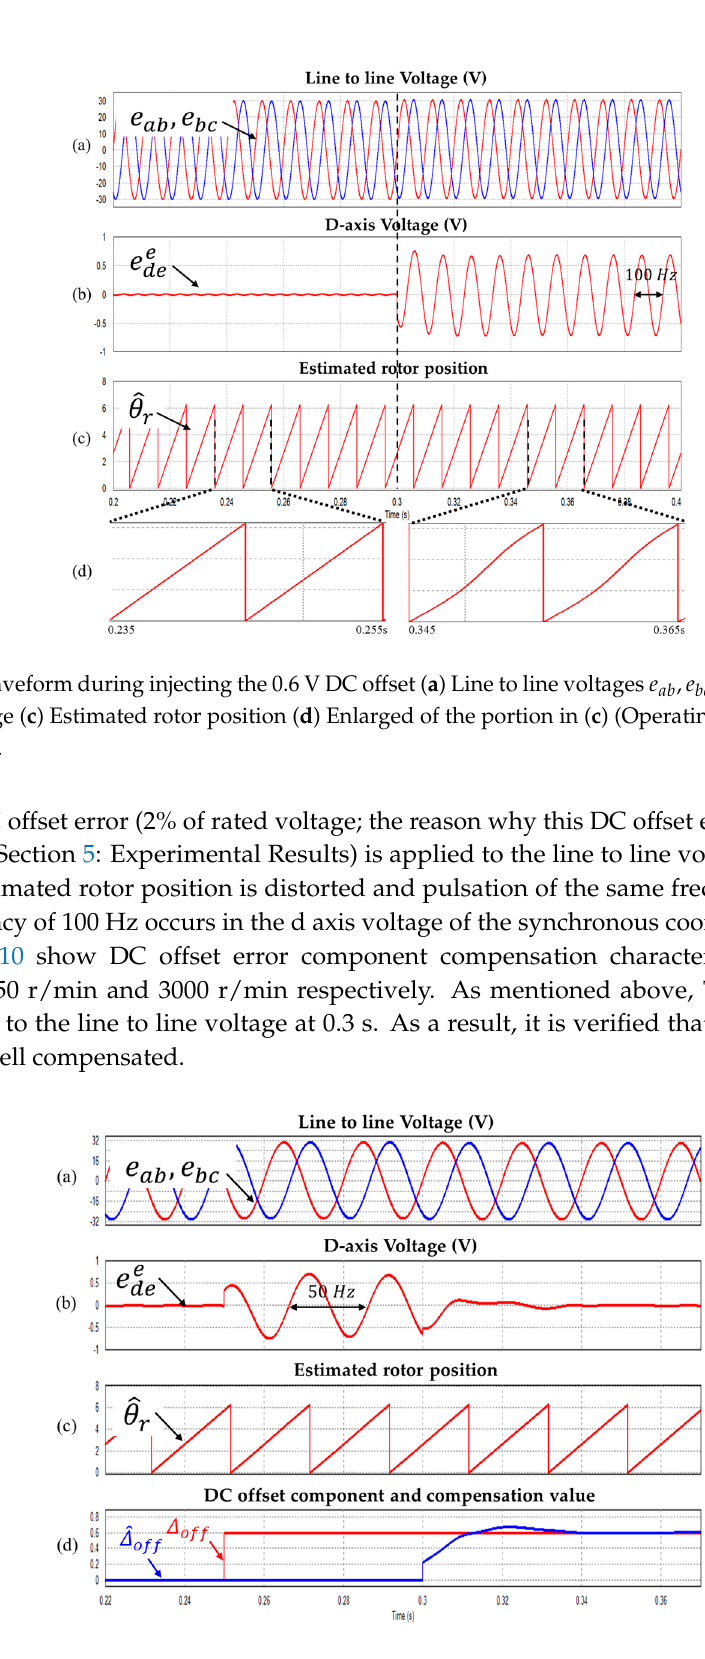
Figure 8. Waveform during injecting the 0.6 V DC offset ( a ) Line to line voltages e ab , e bc ( b ) Synchronous